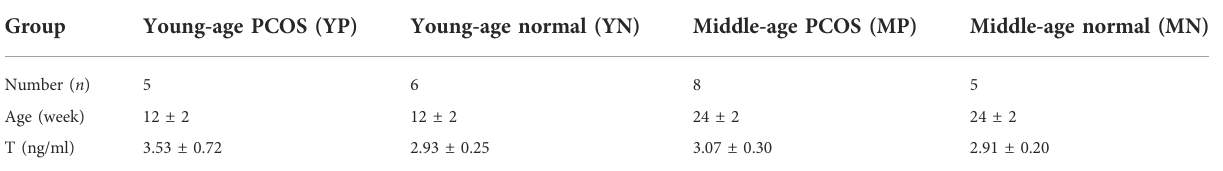
TABLE 1 Basic information of mice in each